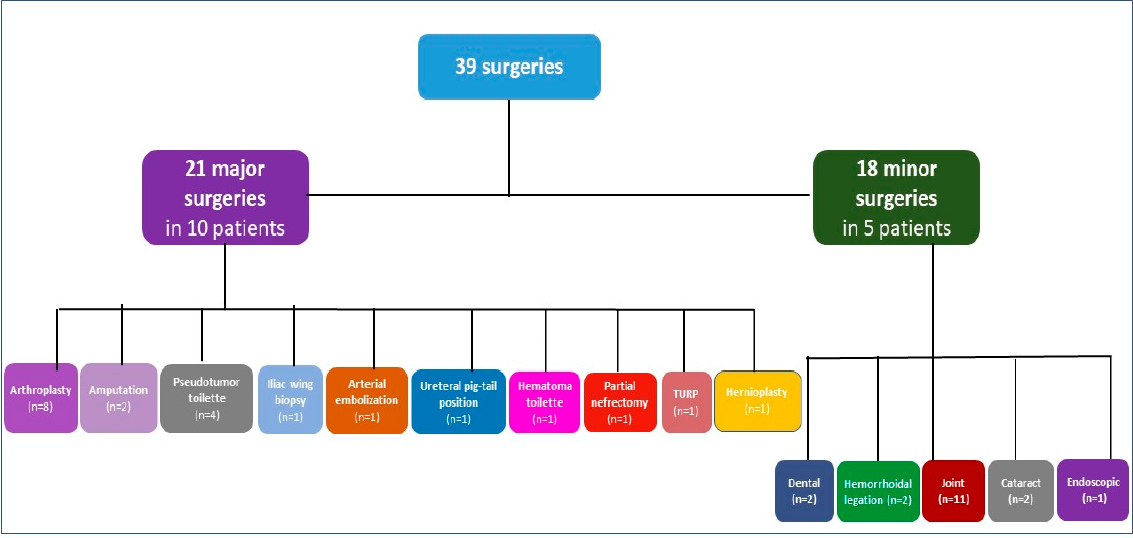
Figure 1. Types of surgeries in patients with hemophilia A and inhibitors. n refers to the number of surgeries. Patients with both minor and major surgeries are counted in both categories; TURP transurethral resection of the prostate.